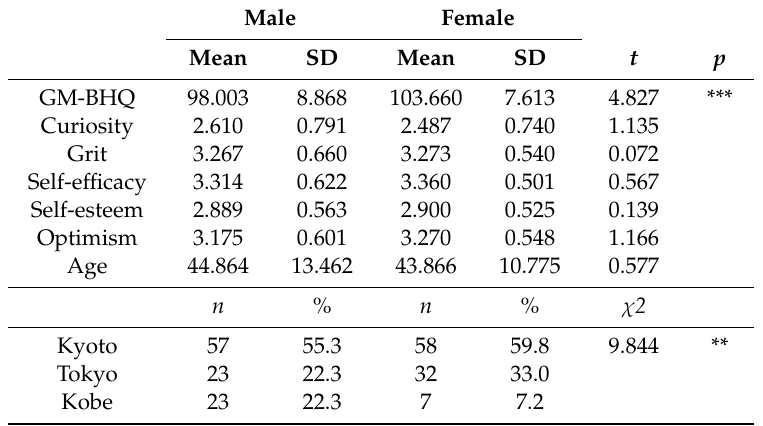
Table 2. Statistical di ff erences between male and female participants.